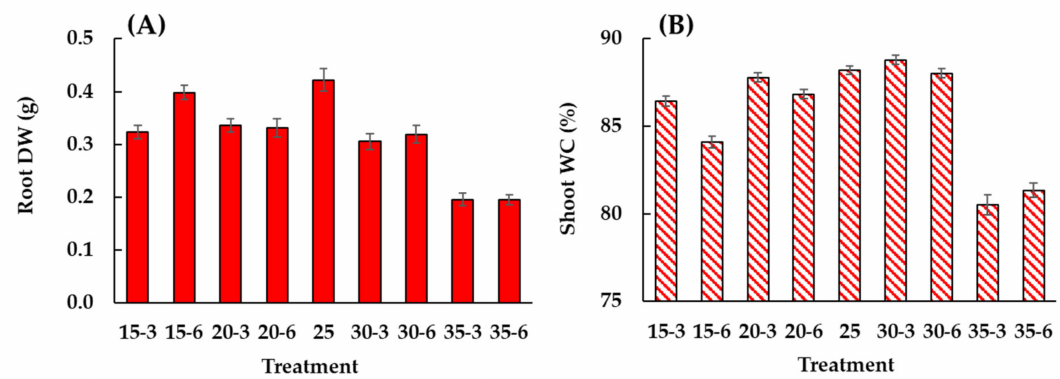
Figure 5. Root dry weight ( A ) and shoot water content (WC) ( B ) of coriander on day 18 after transplanting under di ff erent root-zone temperatures and stress periods. Data are shown as mean ± SE, n =